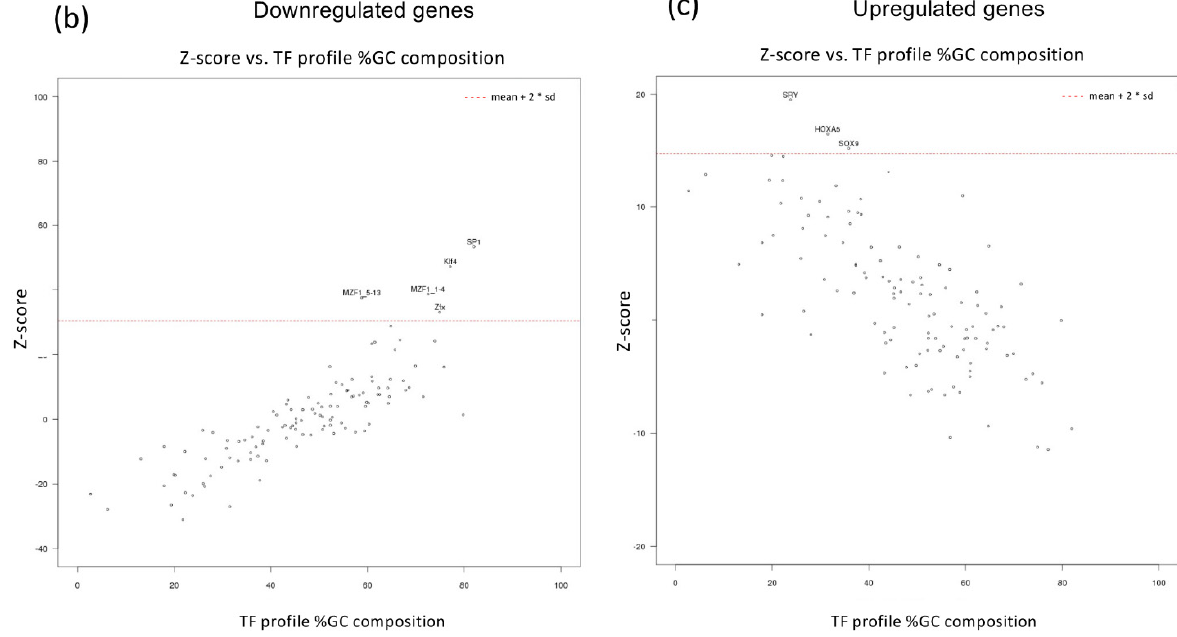
Figure 4. Enrichment analysis of transcription factor binding motifs in the regulatory regions of genes modulated by MEOX2 knock-down. ( a ) All DEGs (both down- and upregulated, in both BT273 and BT379 cells, by MEOX2 KD) were subjected to enrichment analysis of TF binding motifs using oPOSSUM-3 software. ( b ) Only downregulated DEGs analyzed as in ( a ). ( c ) Only upregulated DEGs analyzed as in ( a ). The names of the significantly enriched transcription factor binding motifs (Z score > mean + 2 SD) are